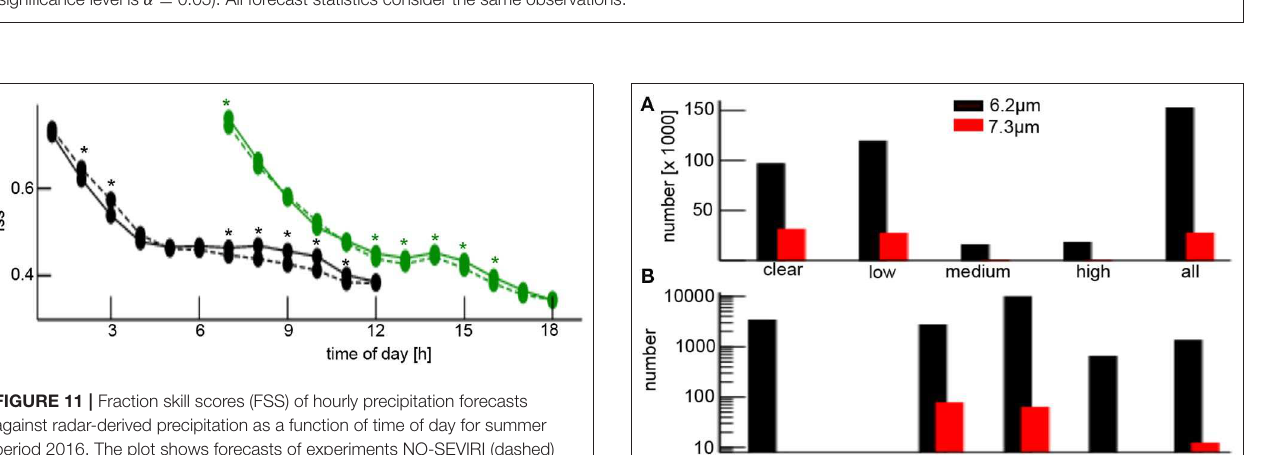
FIGURE 10 | Forecast verification of radiosonde relative humidity for the summer period 2016 for different initial times and lead times. Results are subject to initial times (06 and 00 UTC shown in left panel and 018 and 12 UTC shown in right panel) with lead times 6 h (black) and 12 h (red) for the experiments SEVIRI-NEW (solid line) and NO-SEVIRI (dashed). Observations are present at 00 h and 12 h. The stars denote statistically significant differences in the scores between experiments (significance level is α = 0.05). All forecast statistics consider the same observations.